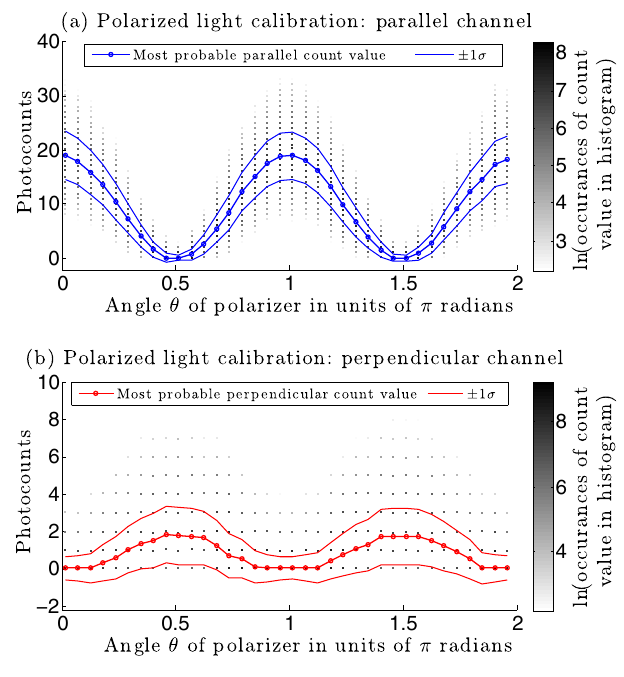
Figure 2. Polarized calibration measurements as a function of inci- dent light polarization angle. Photocounts are given per 1min, 7.5m altitude bin. At angle θ = 0, the calibration cube polarizer is aligned completely with the parallel measurement channel. At θ = 0 . 5 π , it is aligned completely with the perpendicular channel. The grayscale points indicate the extent of scatter in the measurements for each channel. The colour bar indicates the natural logarithm of the num- ber of data points at each location, which is the result of producing a histogram for each angle θ . Data points from all 16000 altitude bins, for all individual minutes of measurement at the angle theta (typically 3 to 5min), are included in the histograms. The truncated distribution of points (because only positive photons may be mea- sured) is evident. Each histogram was fit with a sixth-order polyno- mial in order to determine the location of the peak photocount rate. This often differed significantly from the mean of the photocount values at that angle and was taken to be the most probable value. The most probable photocount values are given by the blue points (parallel channel; a ) and red points (perpendicular channel; b ). The thick blue and red lines trace these data points as a visual aid; they are not fit lines. The thin blue and red lines give the ± 1 σ standard deviation of the point distribution at each angle. Note the different y -axis limits for each plot; the parallel count rates are far larger than the perpendicular count